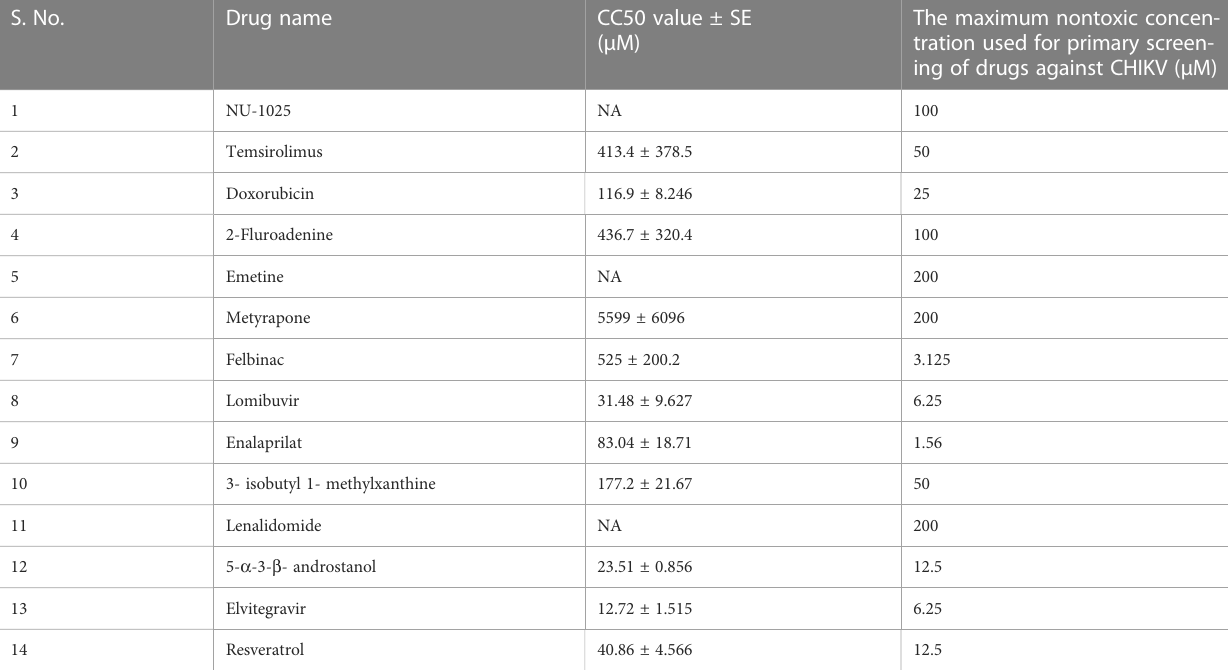
TABLE 2 CC50 values and maximum non-toxic concentration of the drugs. S.